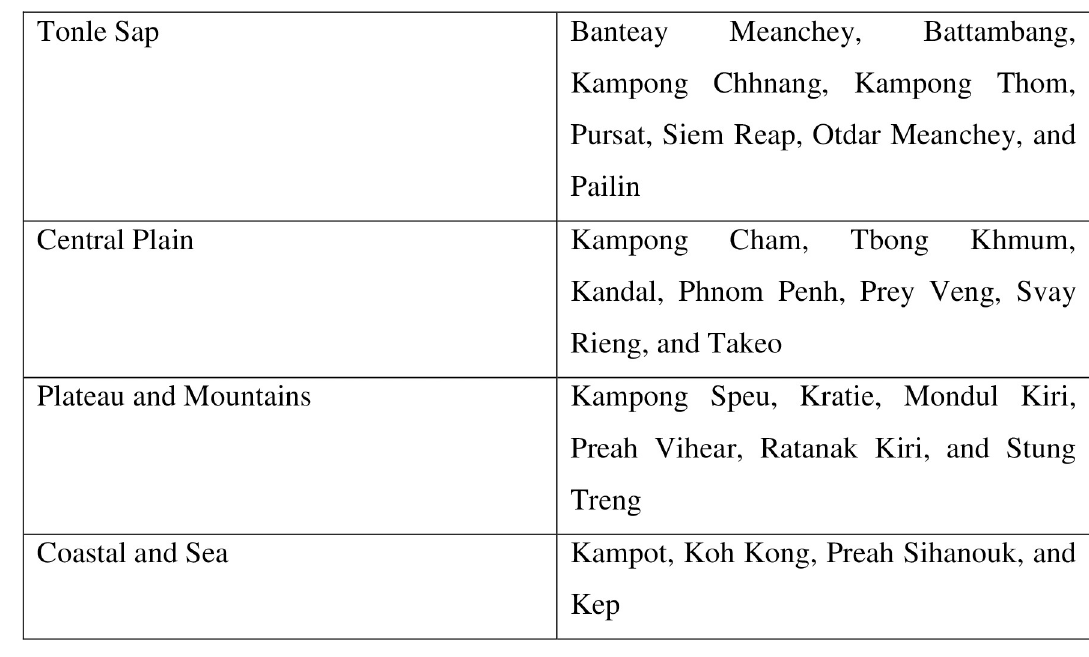
Fig 1. Geographical